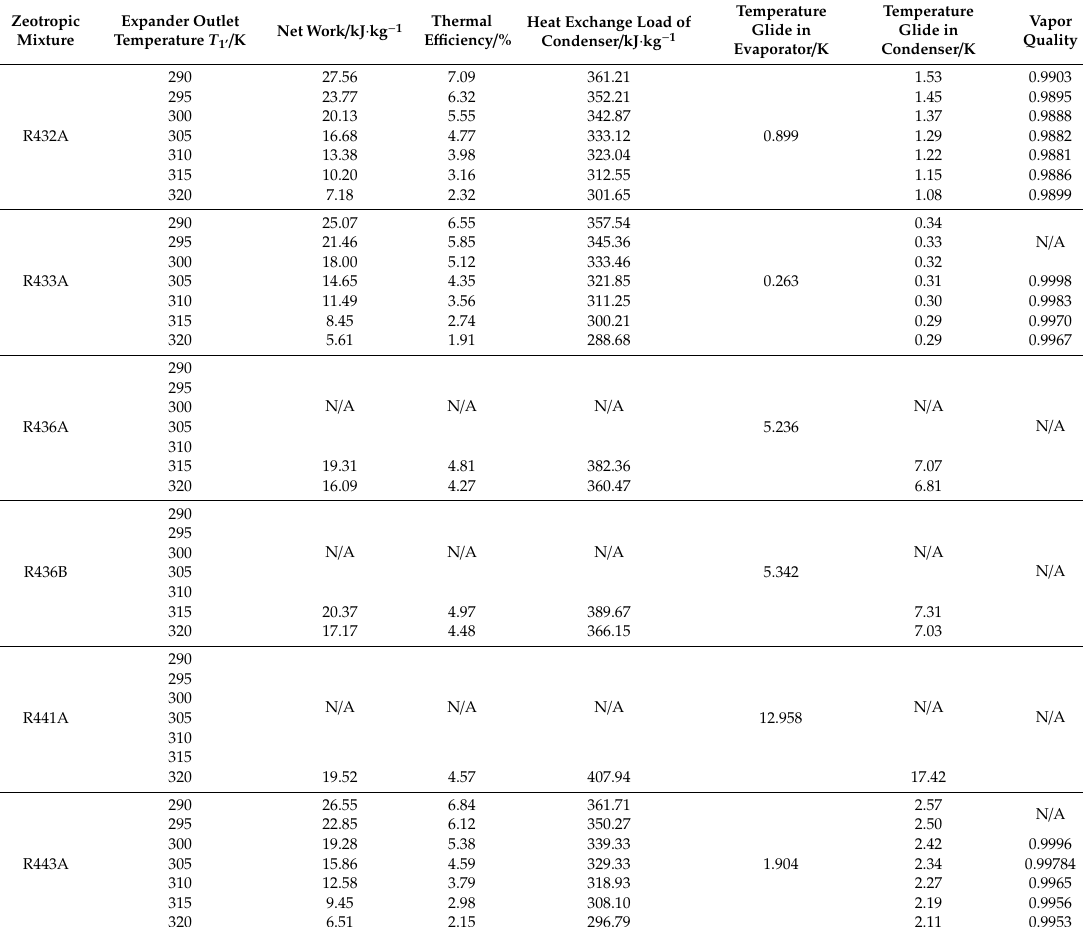
Table 8. Thermodynamic performance of six zeotropic mixtures when expander outlet temperature is known and considering isentropic e ffi ciency of